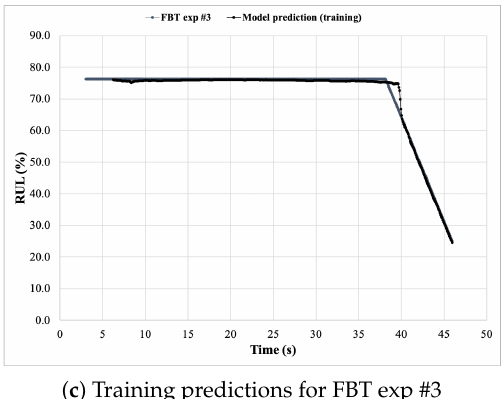
Figure 9. RUL predictions of the deep learning model trained on FBT Experiments 2 and 3 and tested on Experiment 1. The gray background in ( a ) conveys that the digital twin was tested on this FBT